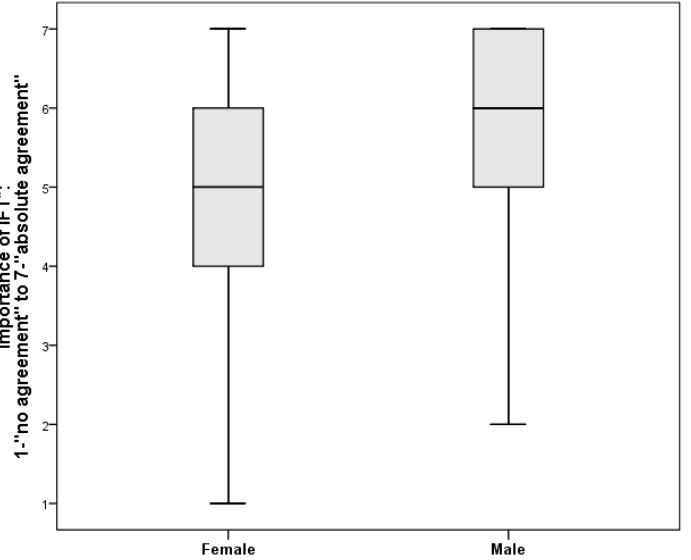
Figure 2. Comparison with boxplots: IFT (Intensive and fulfilling training)-Male vs. Female. A higher age correlated significantly positively with the motives “health promotion” (rs = 0.170) and “experience of nature” (rs =